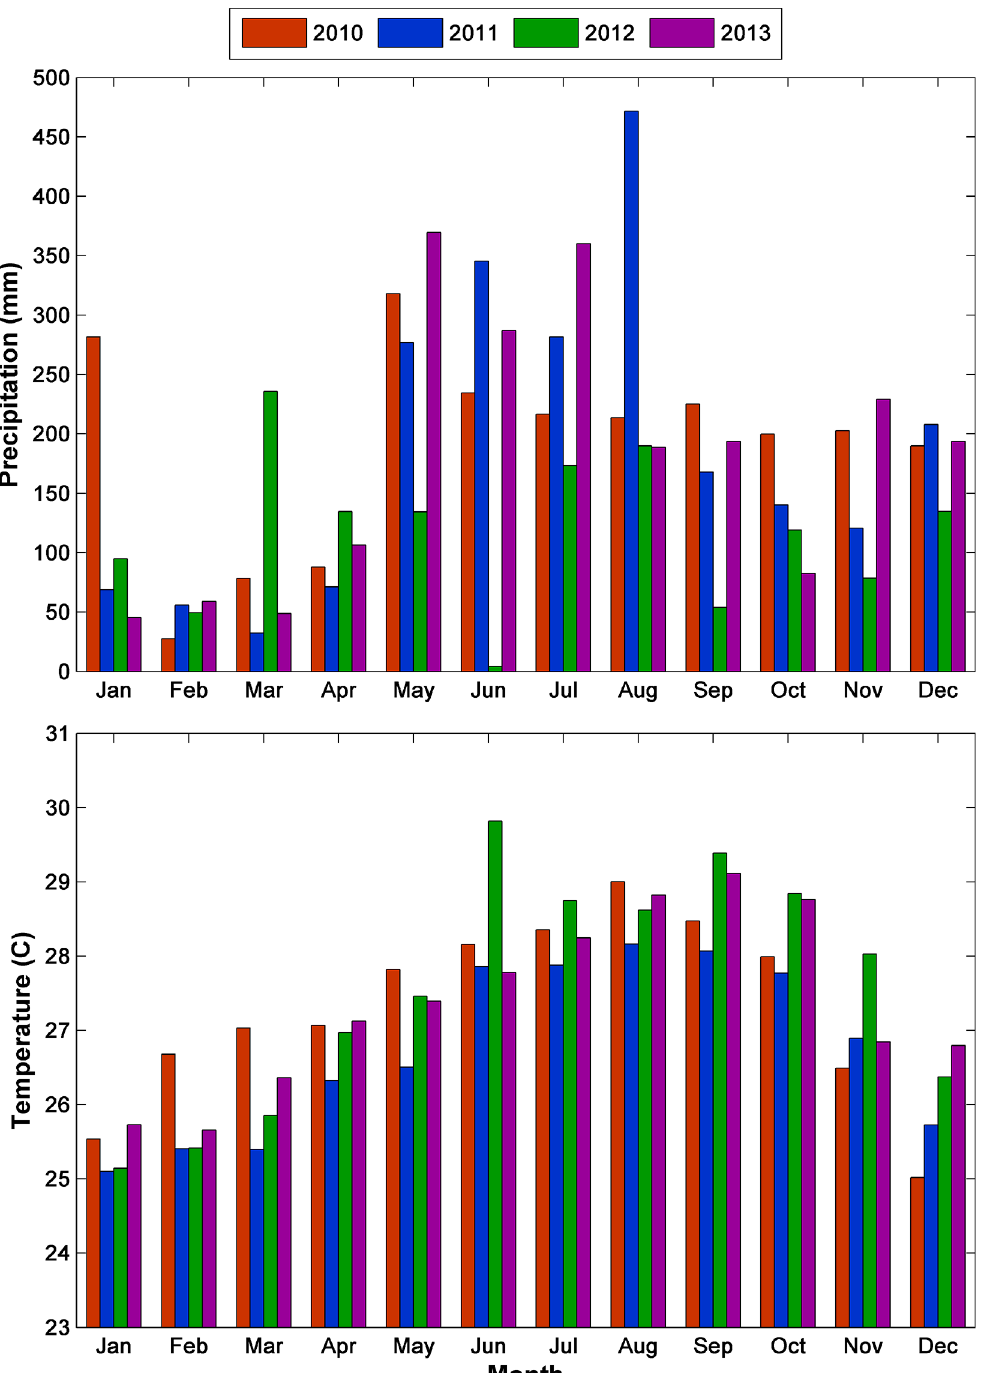
Fig 7. Monthly total precipitation (top) and mean temperature (bottom) by year. The highest incidence of DF cases occurred in 2010 and 2012 during which temperatures were highest in spring during 2010 and fall and early winter during 2012. The year 2011 had both the lowest DF incidence and the lowest temperatures. The year 2013 had moderate precipitation and temperatures but low DF